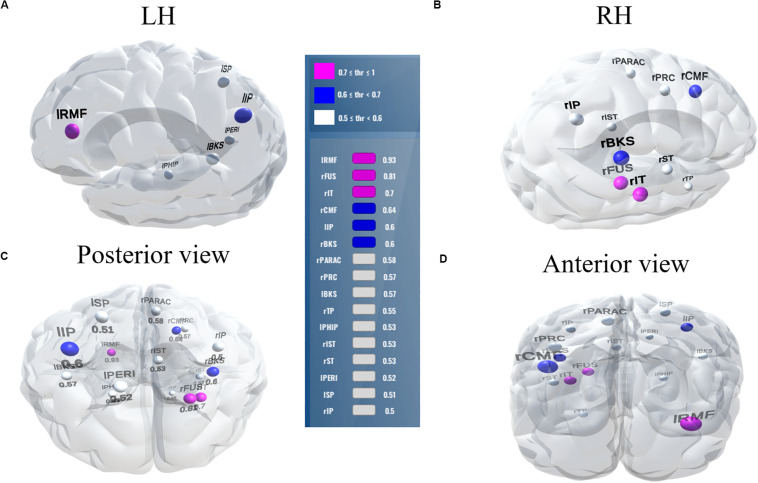
Stable (most consistent) neural network that distinguishes NH and HI listeners during noise-degraded speech processing. 16 top selected ROIs, 78.7% group classification. (A) LH; (B) RH; (C) Posterior view; (D) Anterior view. lRMF, rostral middle frontal L; rIT, inferior temporal R; lIP, inferior parietal L; rPARAC, paracentral R; lPHIP, para hippocampal L; rST, superior temporal R; lPERI, pericalcarine L; rIP, inferior parietal R. Otherwise as in Figure 6.